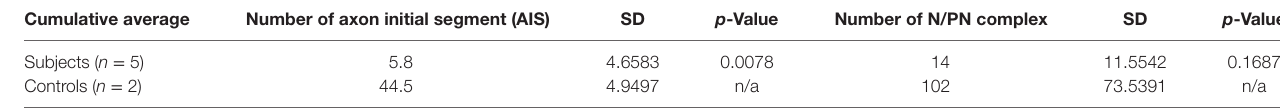
Regions of cortex adjacent to microinfarcts demonstrated multiple irregularities. Number of AISs were significantly decreased by 87% in average number of AIS when compared to controls (p = 0.0078). Number of node–paranode complex was also decreased by 86.2% in average number of node–paranode complex when compared to controls (p = 0.1687).